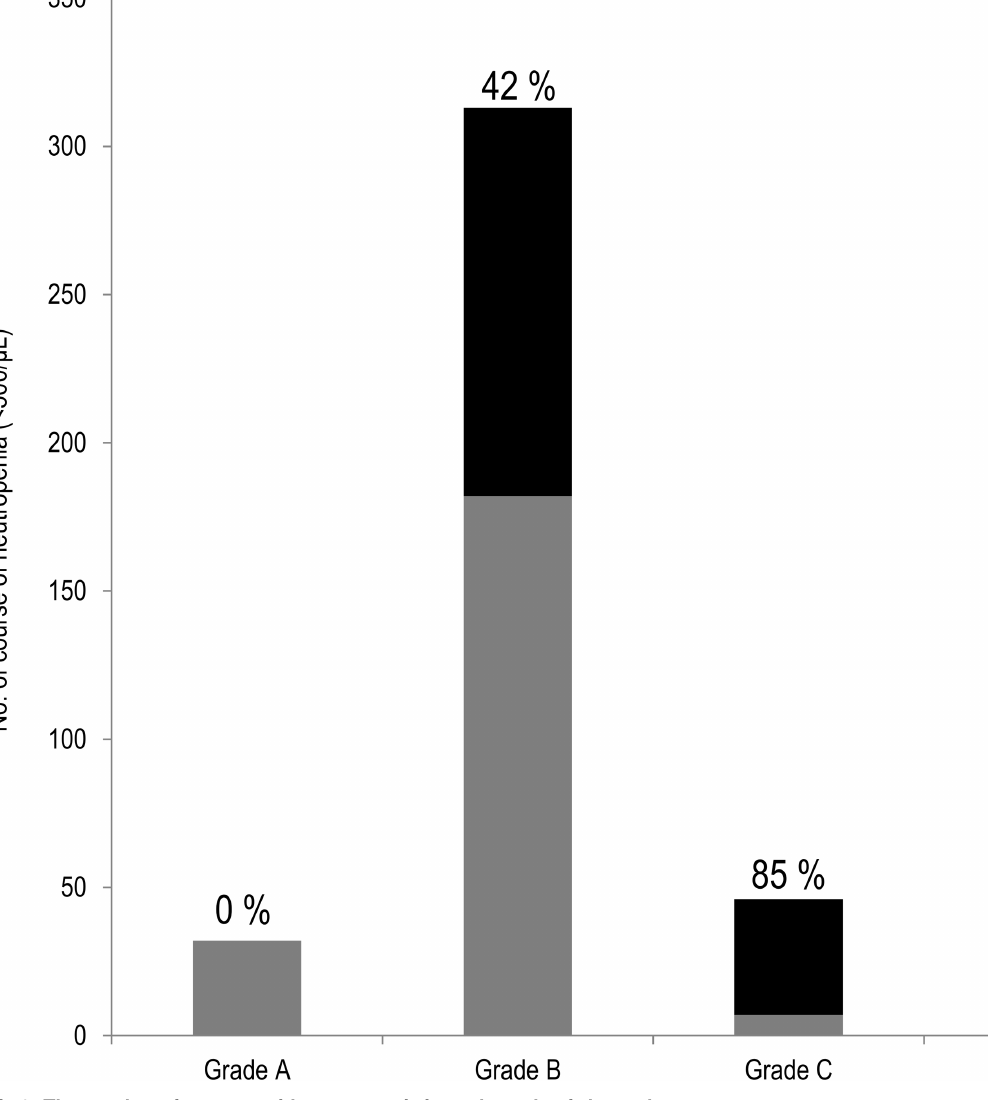
Fig 2. The number of courses with neutropenia in each grade of